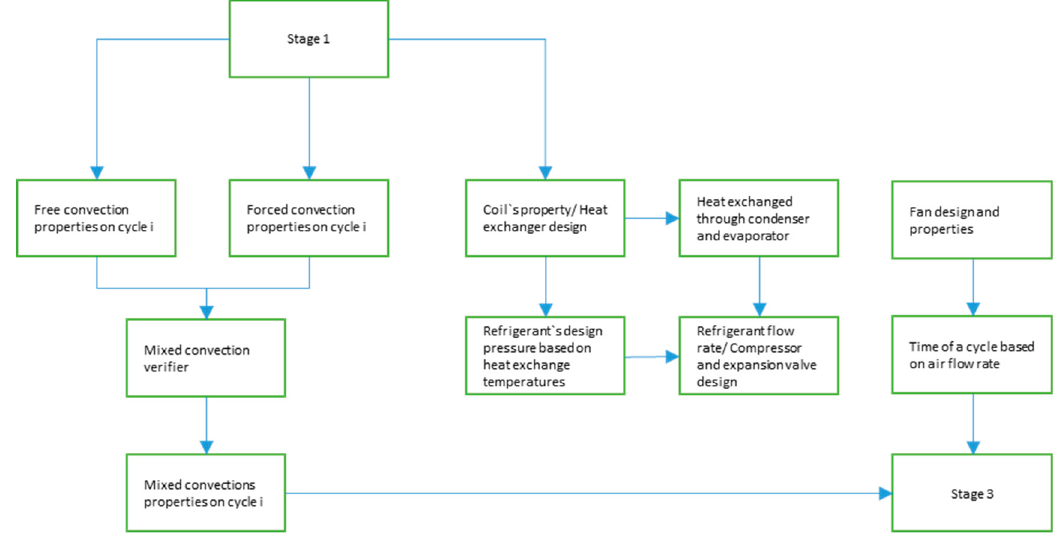
Figure 3. Stage 2 of algorithm. Heat flow analysis between components, air and food. Component design derived from Equation (18) to (24).